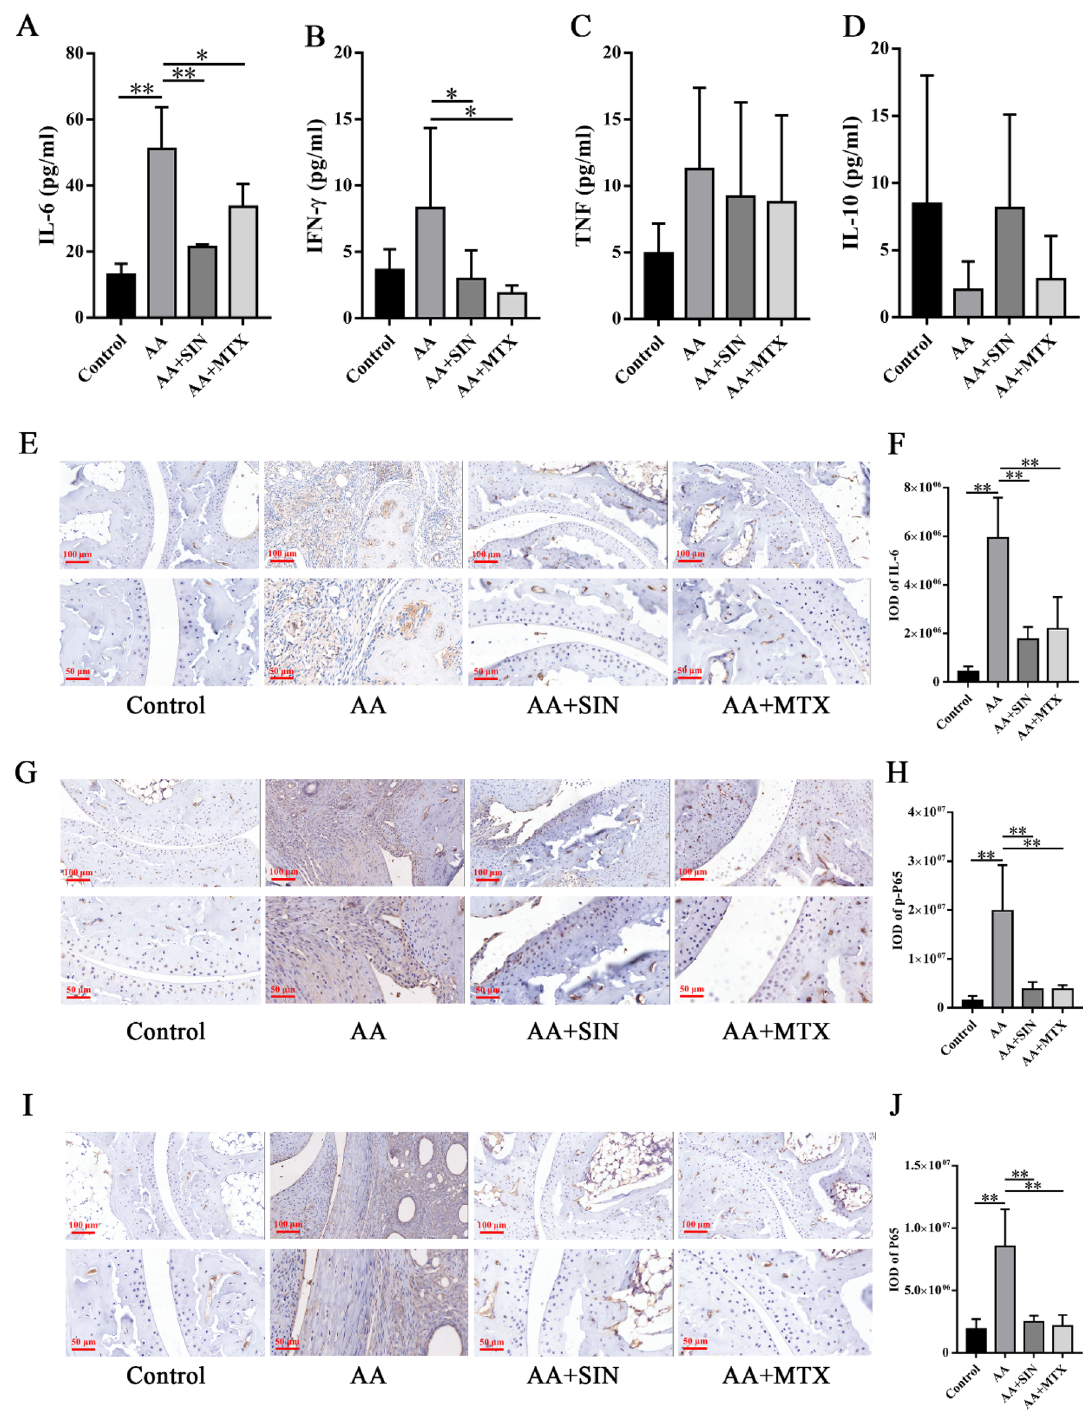
Figure 3. Sinomenine reduced systemic and local inflammation in AA mice. ( A ) The concentration of IL-6 in the serum of mice. ( B ) The concentration of IFN-γ in the serum of mice. ( C ) The concentration of TNF in the serum of mice. ( D ) The concentration of IL-10 in the serum of mice. The data are shown as the mean ± SD (n = 6). ( E ) IHC staining was used to detect IL-6 in ankle joint sections. Representative images are shown. ( F ) Statistical analysis was applied to calculate the IOD of IL-6 in ( E ). The data are shown as the mean ± SD (n = 3). ( G ) IHC staining was used to detect p-P65 in ankle joint sections from the mice. Representative images are shown. ( H ) Statistical analysis was applied to calculate the IOD of p-P65 in ( G ). The data are shown as the mean ± SD (n = 3). ( I ) IHC staining was used to detect P65 in ankle joint sections from the mice. Representative images are shown. ( J ) Statistical analysis was applied to calculate the IOD of P65 in ( I ). The data are shown as the mean ± SD (n = 3). *p < 0.05, **p < 0.01. “n = 3” represents three mice with representative joint diameters; the arthritis scores were selected from each group to prepare ankle joint tissue sections, and one representative picture from each mouse was used for quantification